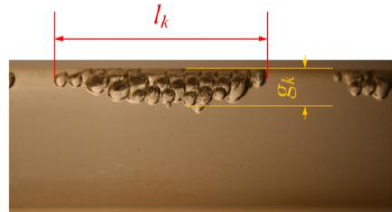
Fig. 2. Presentation of parameters: length l k and depth g k of the gas bubble cluster.